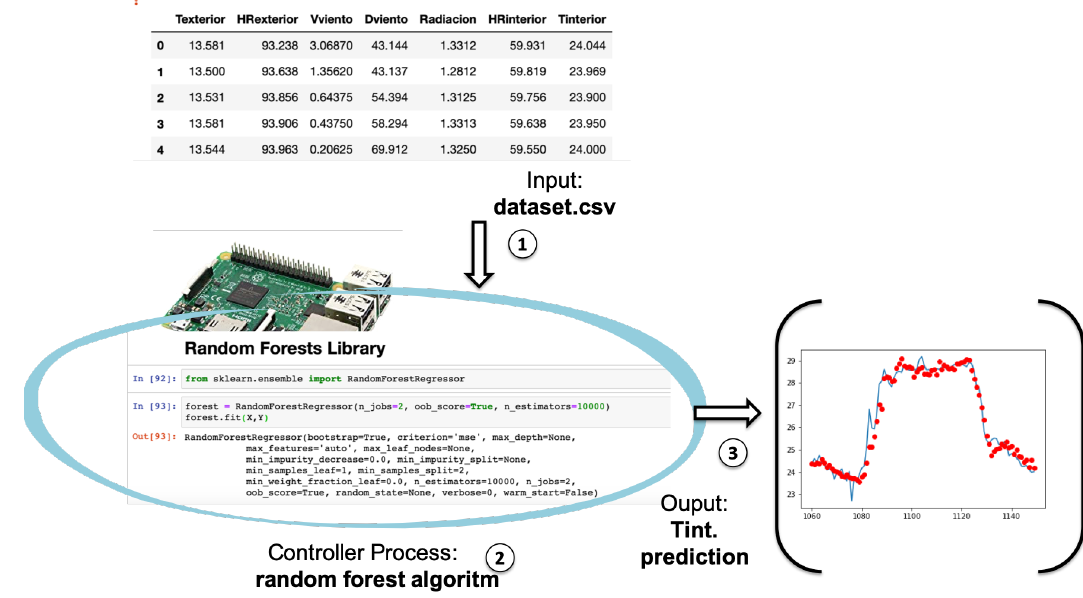
Figure 5. Temperature prediction process in the greenhouse using learning dataset and Python library in embedded controller. The model used is the paradigm random